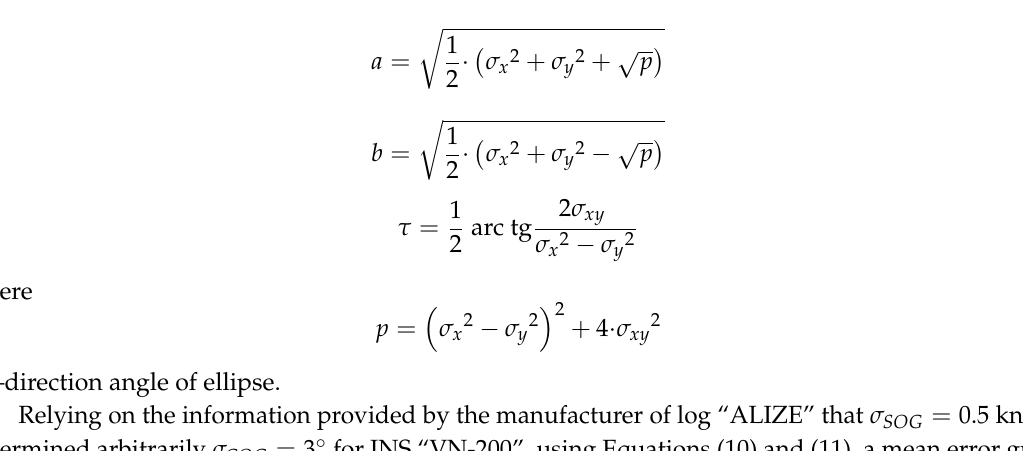
Figure 5. Mean error of coordinates as a function of distance covered (adopted P ( k = 0 ) = SOG = 1 m/s, COG = 90°).